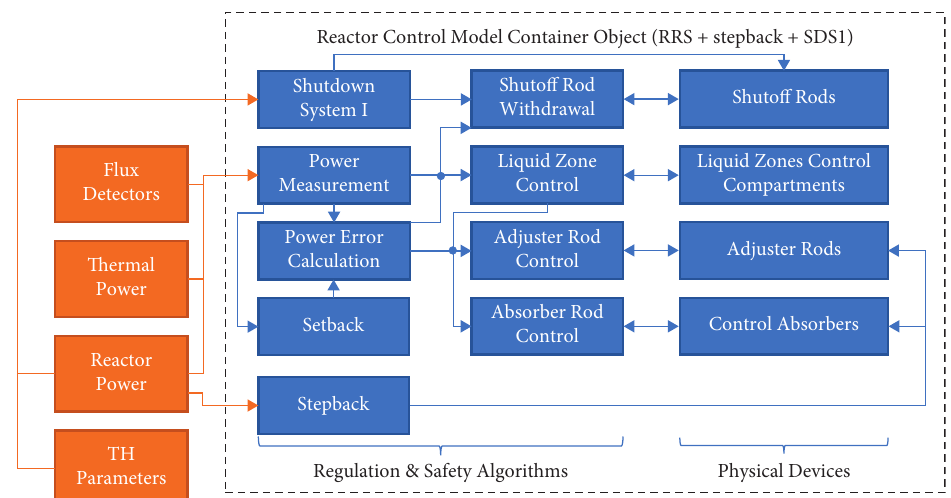
Figure 4: Reactor control model as implemented in this work. An overview of how different components are connected is shown along with the TRACE and PARCS model parameters that provide input to the control